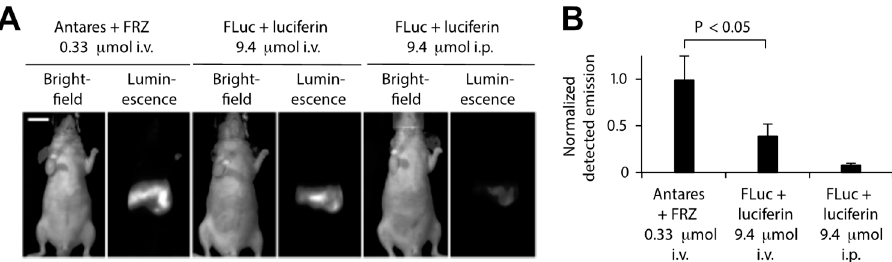
Figure 10. In vivo comparison of Antares and FLuc BRET emission intensities using the substrates furimazine and luciferin, respectively. ( A ) Antares results in a higher BRET emission when intravenously injected with 0.33 µmol furimazine (FRZ) as compared to FLuc when injected i.v. or i.p. with 9.4 µmol of luciferin. ( B ) Normalized emission from Antares and FLuc from multiple mice; n = 5 for Antares; n = 6 for FLuc i.v. and n = 16 for FLuc i.p. Adapted with permission from [141]. Copyright 2016, Springer Nature.